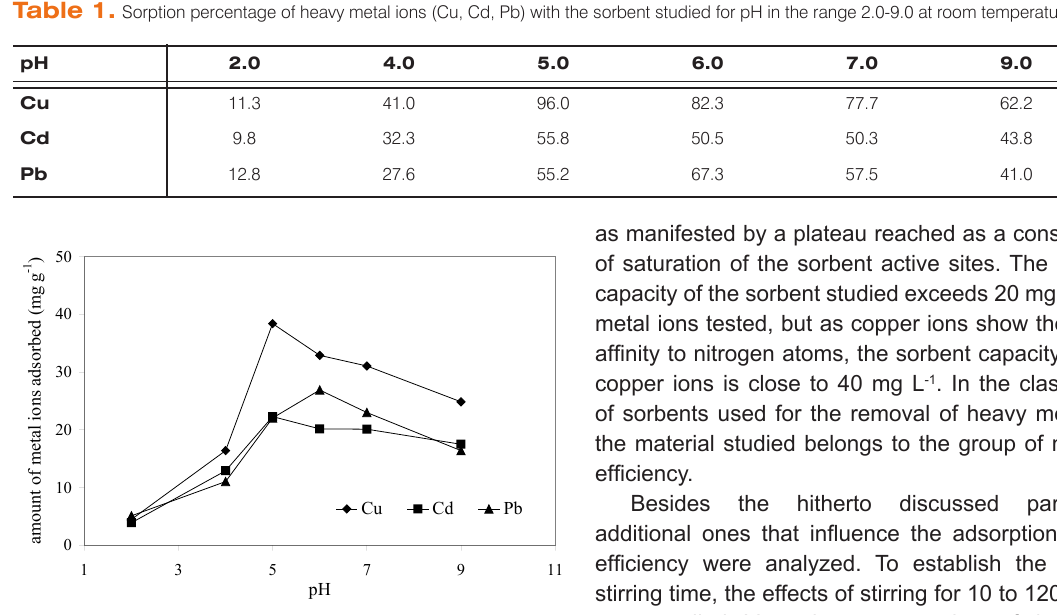
Figure 2. Adsorption of Cu(II), Cd(II) and Pb(II) on the support studied for pH in the range 2.0-9.0; initial concentration of cations 40 mg L -1 , T 298 K.